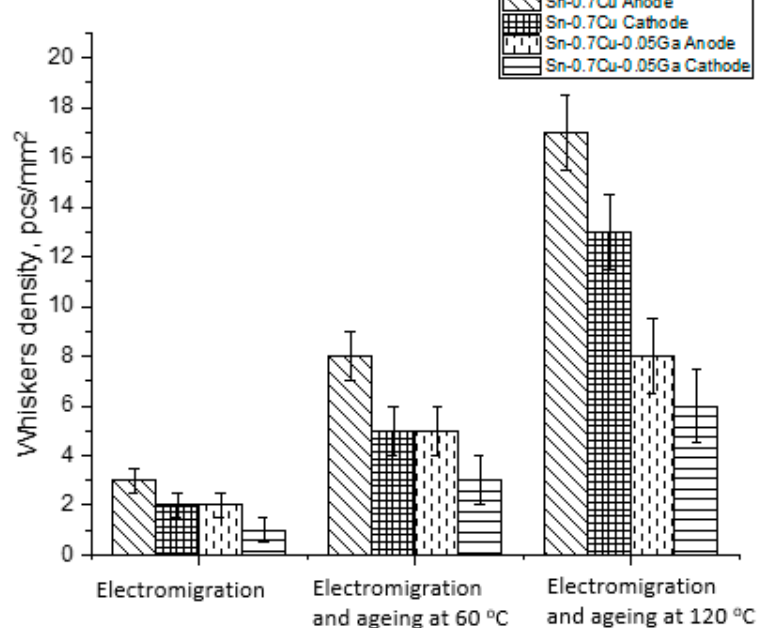
Figure 10. Sn whisker density of Sn–0.7Cu and Sn–0.7Cu–0.05Ga after electromigration with and without thermal ageing, with thermal ageing at 60 °C and 120 °C, at anode and cathode side after 3 days.